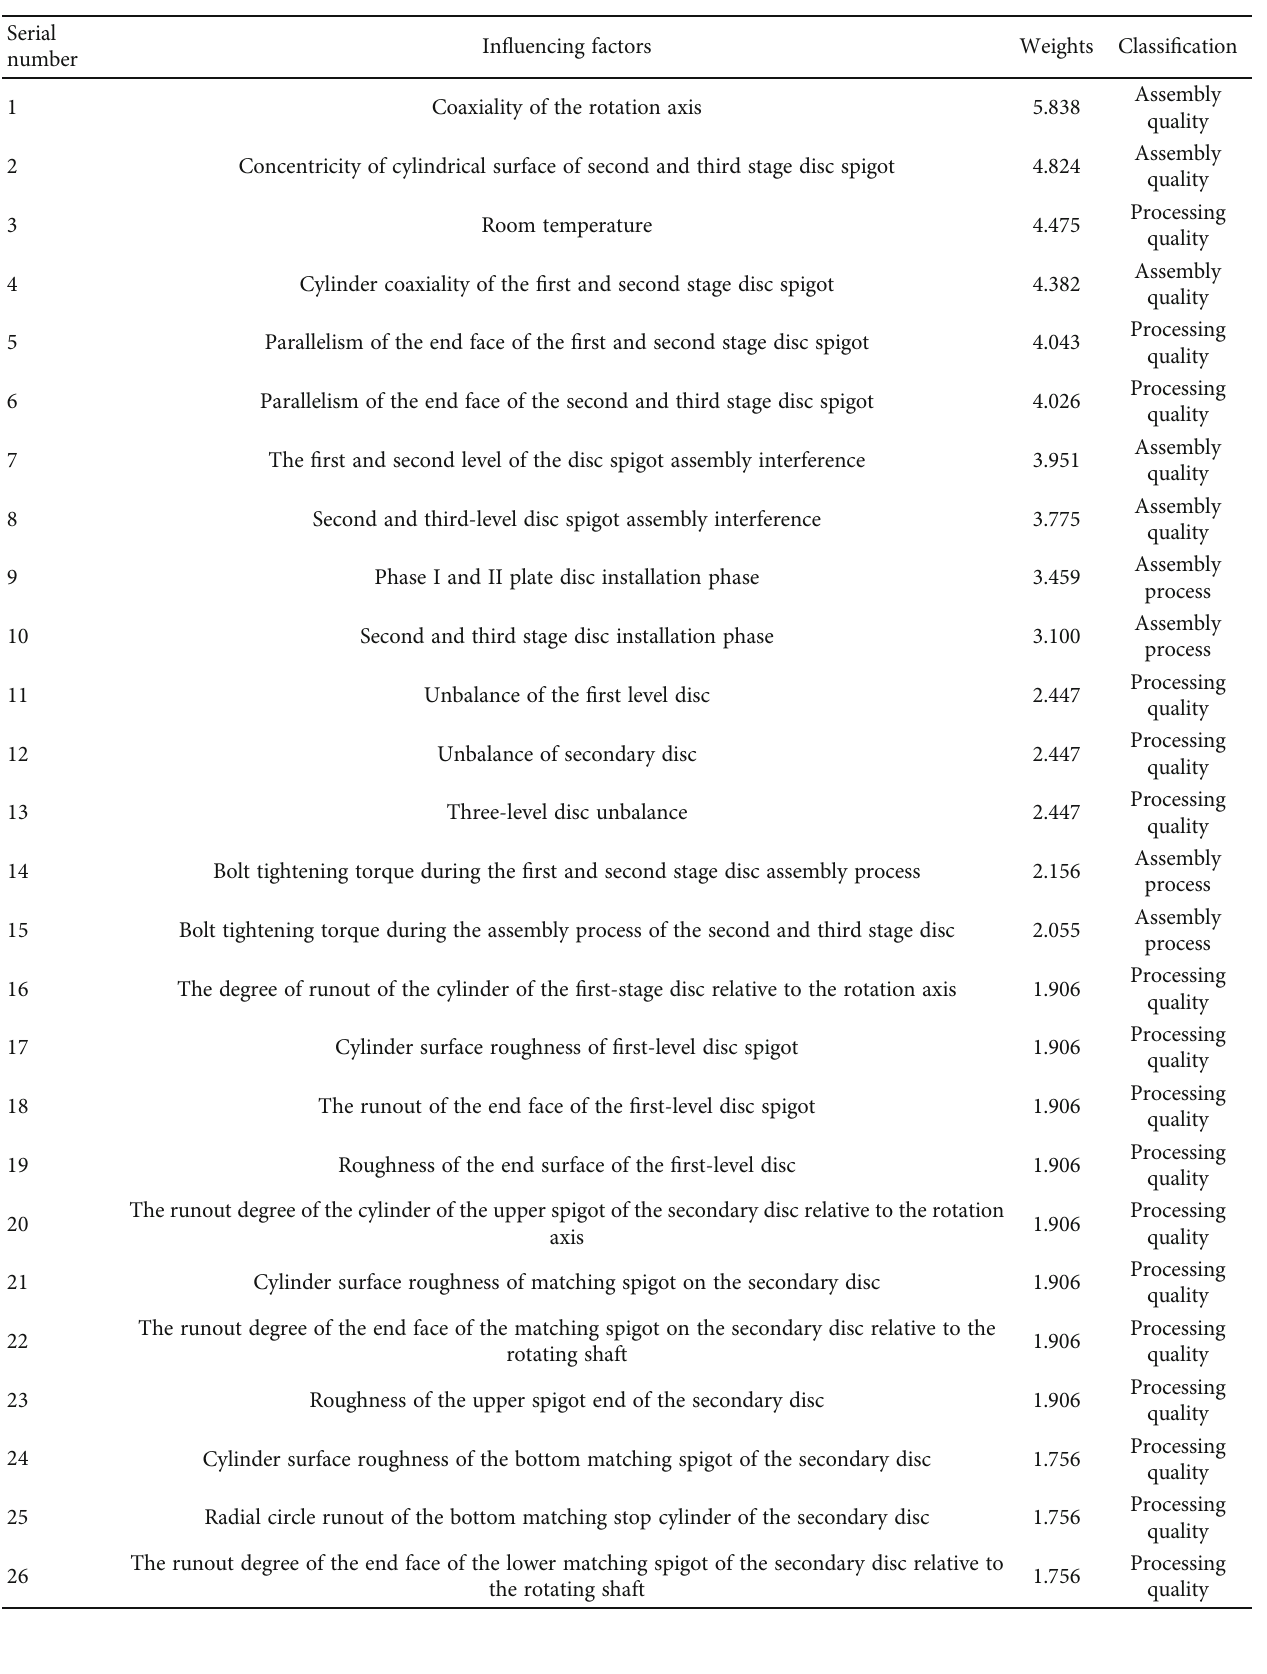
Table 17: Sorting results of key in fl uencing factors of disc assembly